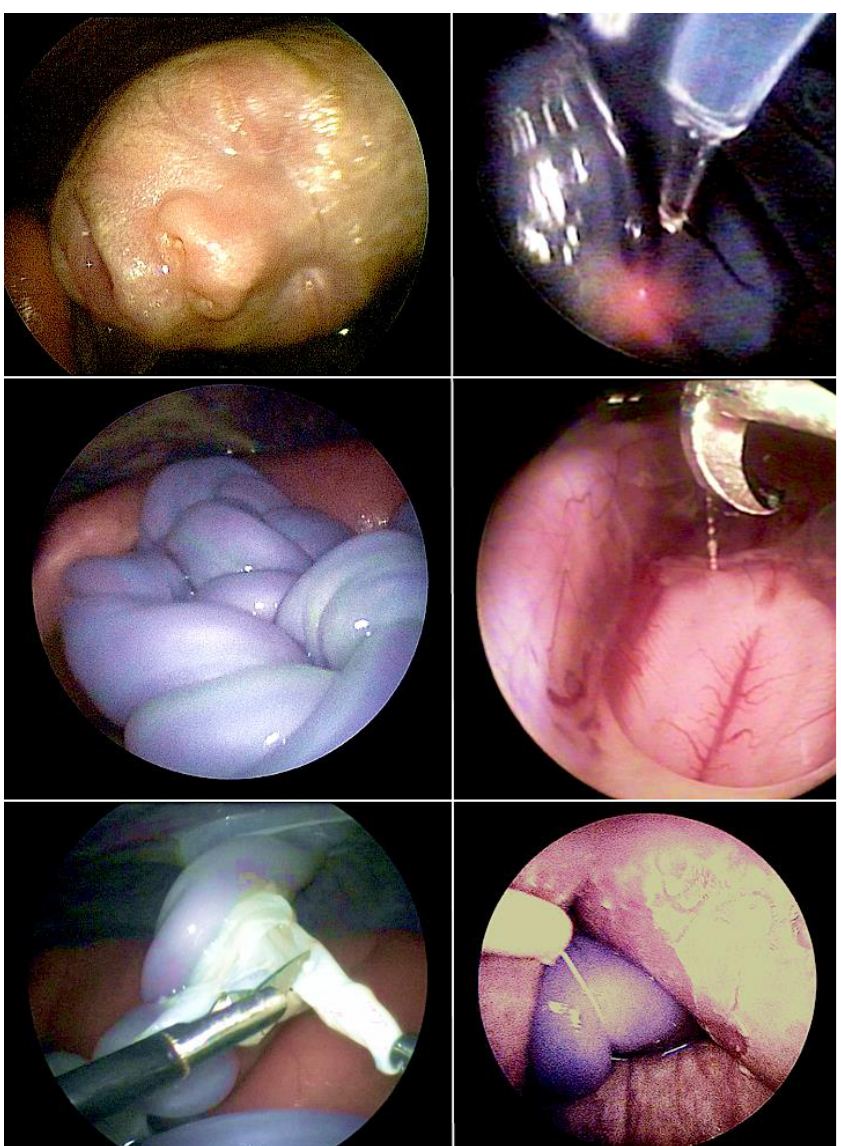
Figure 1. The technique of fully percutaneous partial amniotic carbon dioxide insufflation (PACI) has been invaluable in improving the visualization of both the fetus ( top left ) and intraamniotic contents during complex fetoscopic procedures. Over the past 20 years, I have employed it for fetoscopic laser ablation for twin-to-twin transfusion syndrome (TTTS) ( top right ), umbilical cord transection in monoamniotic twins ( middle left ), during surgery for spina bifida ( middle right ), amniotic band removal ( bottom left ), and during umbilical cord ligation in discordant twins ( bottom right ).